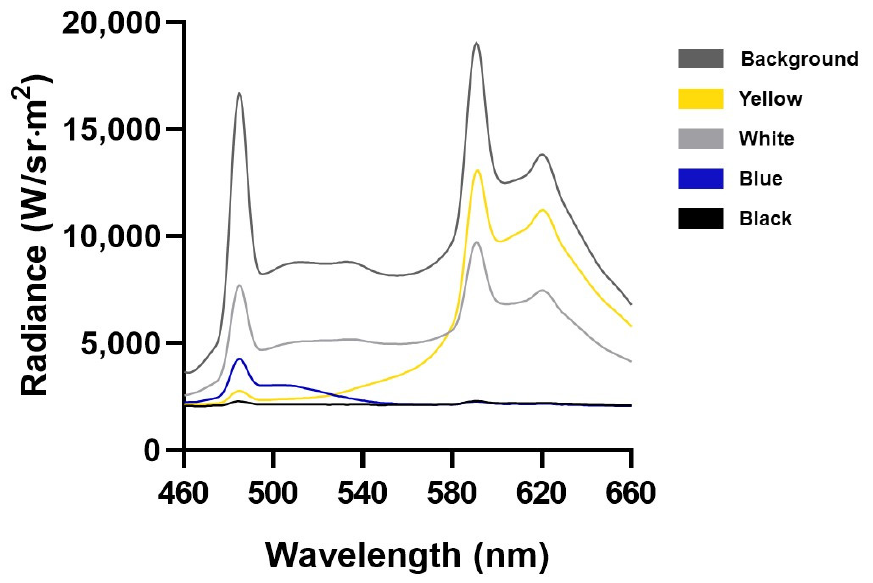
Figure 3. Underwater visible irradiance of four shelters .